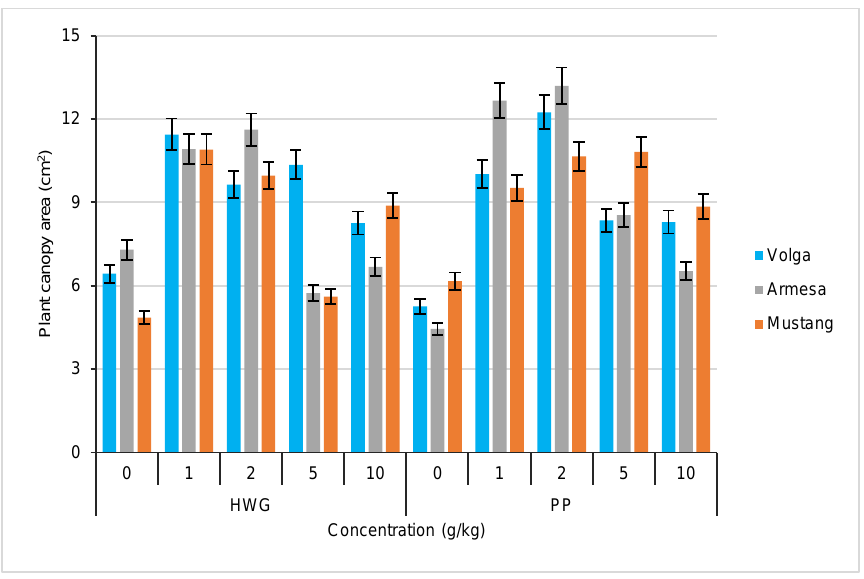
Figure 2. Effect of varying concentrations of hydrolyzed wheat gluten (HWG) and potato protein (PP) on plant canopy area in the sugar beet cultivars Volga, Armesa, and Mustang.